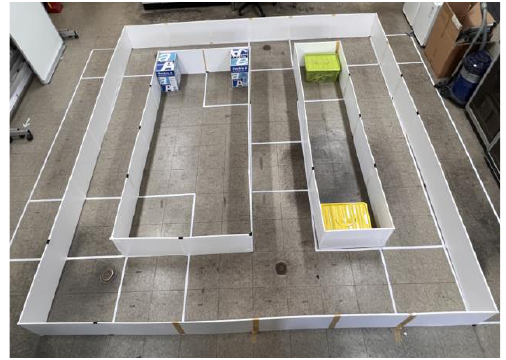
Figure 9. Indoor Autonomous Driving Track.